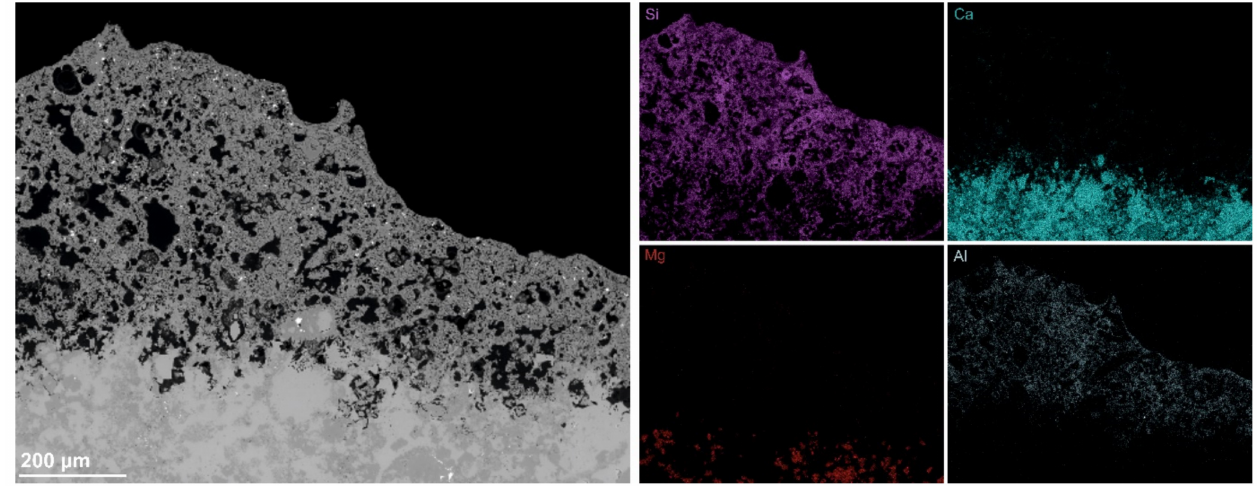
Figure 8. SEM image in backscattered electron mode and EDX elemental mapping (Si, Ca, Mg and Al) of sample